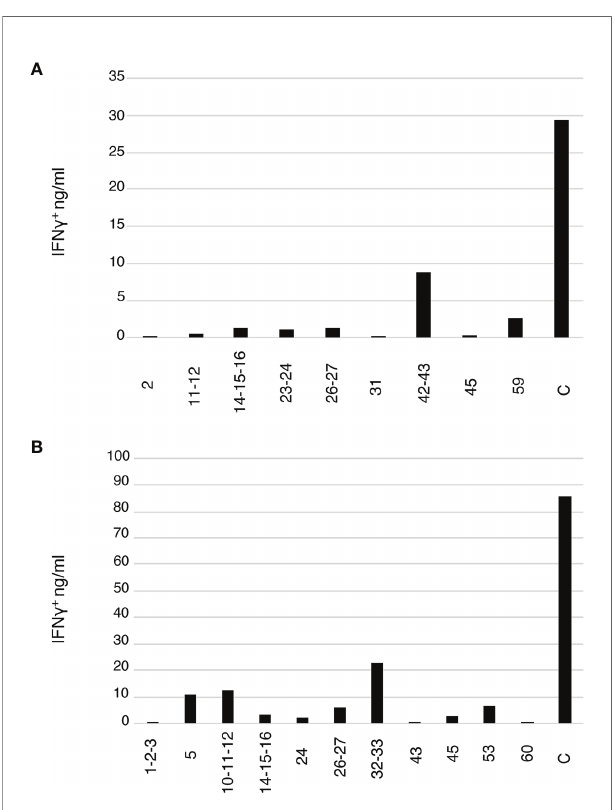
FIGURE 4 | Flu M1 epitope-speci fi c T cell repertoires expanded by single or small clusters of Flu M1 peptides. (A) ND1005 and (B) ND1004 PBMCs were cultured in complete RPMI 1640 + 10% AB serum for 10 days in the presence of IL-2, stimulated with 1 m M of either single peptides or small clusters of Flu M1 peptides. On day 11 cultures were re-stimulated with 2 m M of the matching Flu M1 peptides or PHA as a control (C) for 48 h and the collected supernatants were analyzed for IFN g